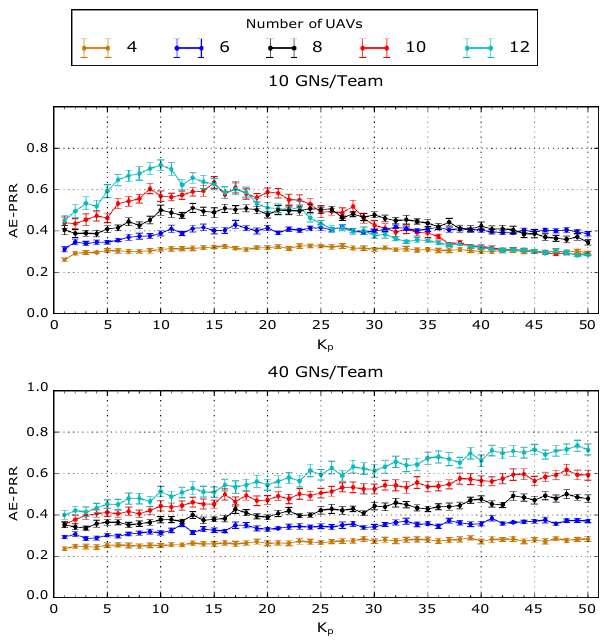
Figure 6. AE-PRR against K p with 3 teams composed of different numbers of GNs.